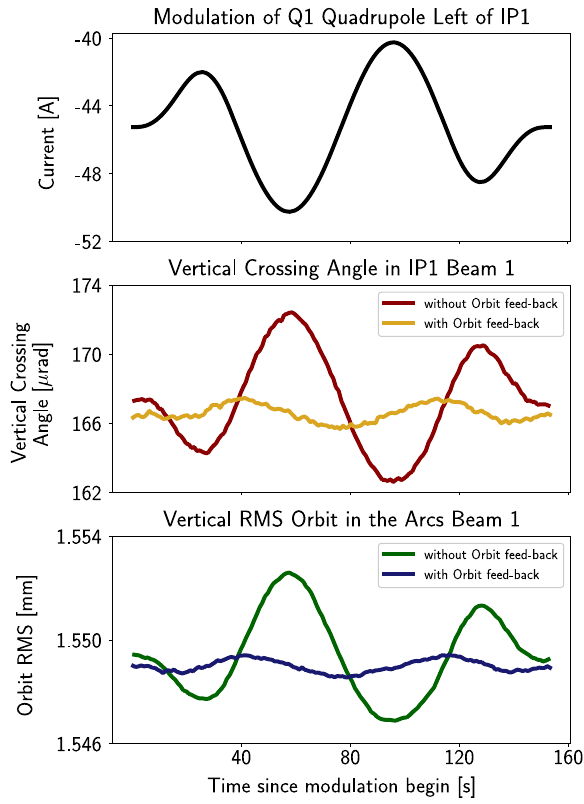
FIG. 26. Orbit leakage during K-modulation measurements performed in the operational configuration of the β (cid:1) ¼ 0 . 3 m.